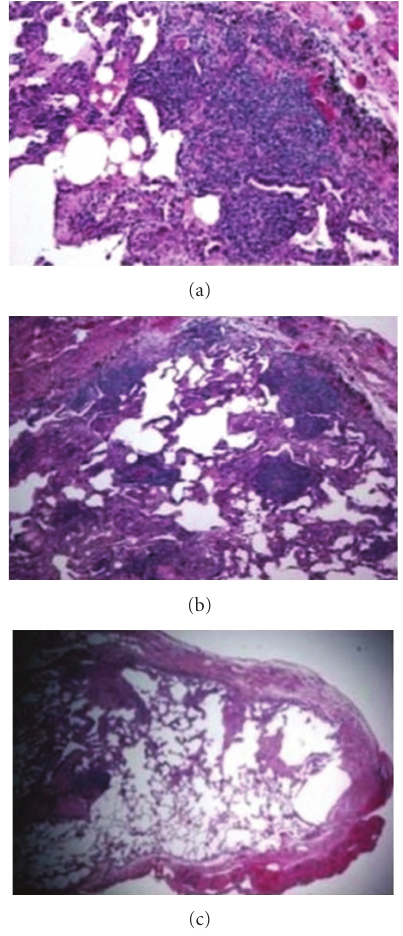
Figure 1: (a) Sections of intraparenchymal lymph node reveal- ing complete e ff acement of normal nodular architecture by monotonous proliferation of small monocytoid lymphoid cells typical of marginal zone B-cell lymphoma. (b) Lung biopsy showing morphologically pulmonary lymphoid infiltrates with small lym- phocytes distributed along the interlobular septae, visceral pleura and vessels, consistent with pulmonary parenchymal involvement by lymphoma. (c) Section of the pulmonary parenchyma showing normal alveolar architecture except in areas close to lymphocytic infiltration where microscopic bullae are